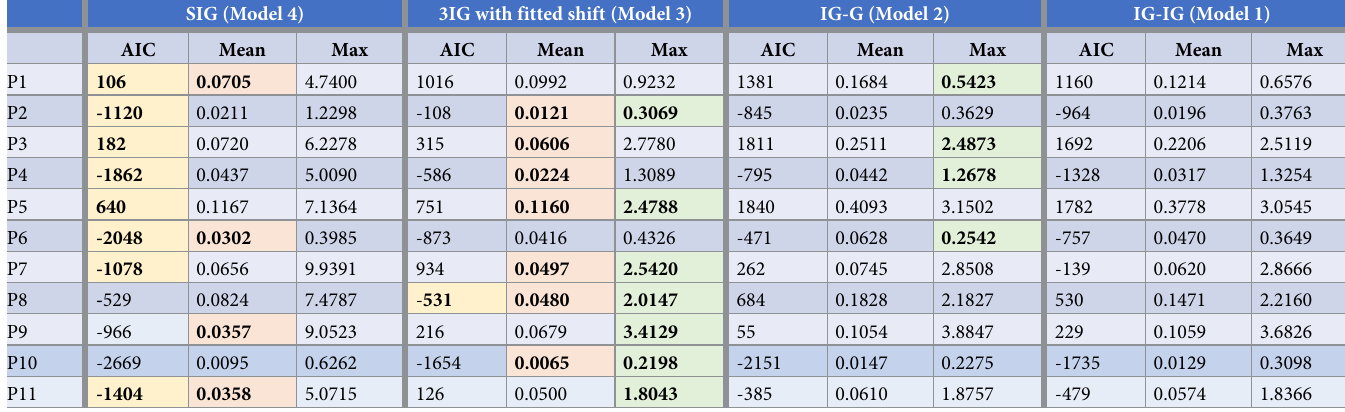
Table 3. Model fit results propofol sedation cohort for Models 1–4.